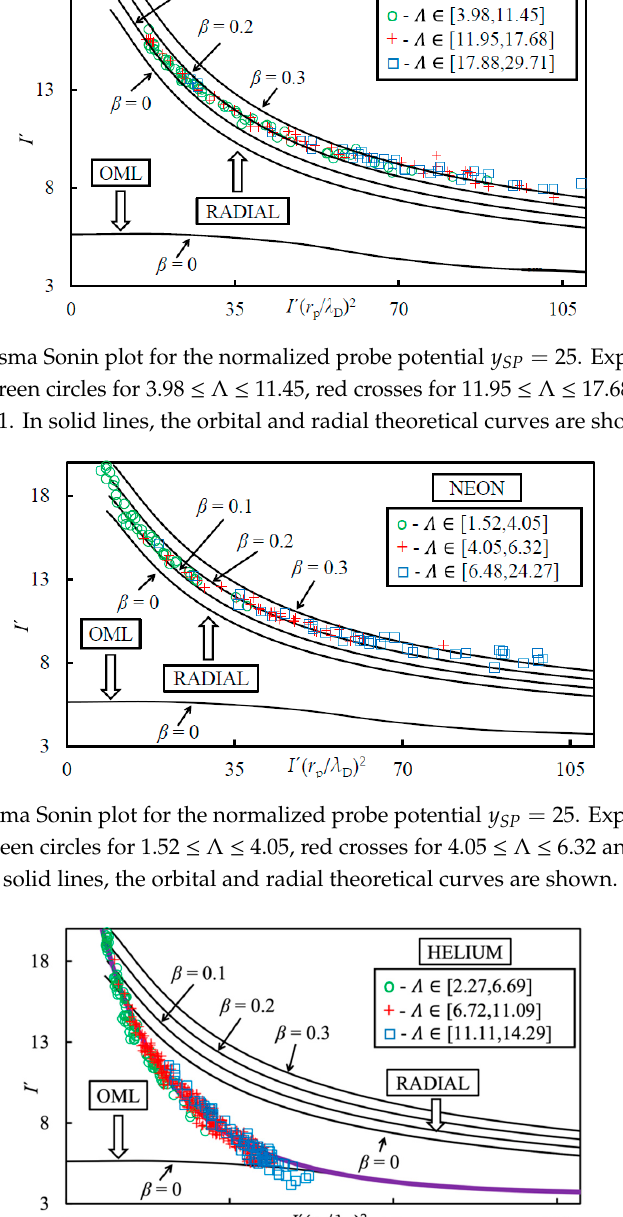
Figure 1. Argon plasma Sonin plot for the normalized probe potential 𝑦 (cid:3020)(cid:3017) = 25 . Experimental data for the argon plasma: green circles for 3.98 ≤ 𝛬 ≤ 11.45, red crosses for 11.95 ≤ 𝛬 ≤ 17.68 and blue squares for 17.88 ≤ 𝛬 ≤ 29.71. In solid lines, the orbital and radial theoretical curves are shown.